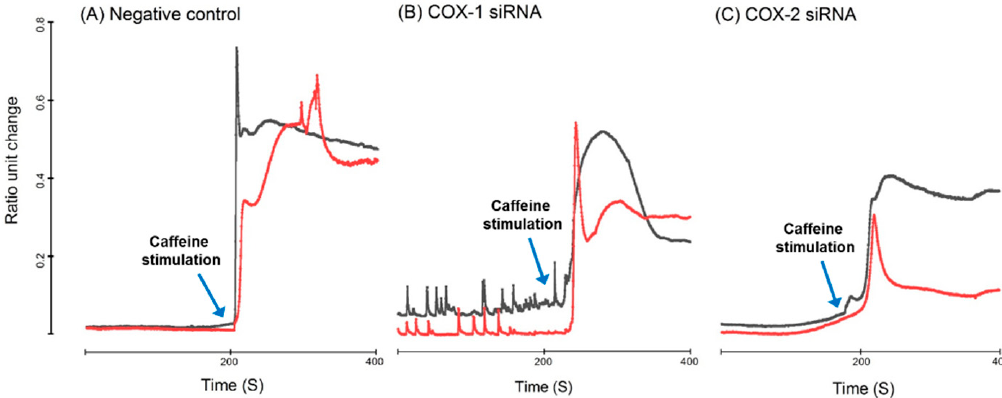
Figure 8. Representative Ca 2 + transient of mouse primary myotubes loaded with Fura-2 / AM in response to 20mM ca ff eine (arrows). Treatment with COX-1 siRNA induced spontaneous Ca 2 + oscillation with reduced response to ca ff eine stimulation. While Ca 2 + oscillation was not observed in myotubes treated with COX-2 siRNA, their response to ca ff eine stimulation was further reduced. ( A ) Negative control; ( B ) COX-1 siRNA knockdown; and ( C ) COX-2 siRNA knockdown.